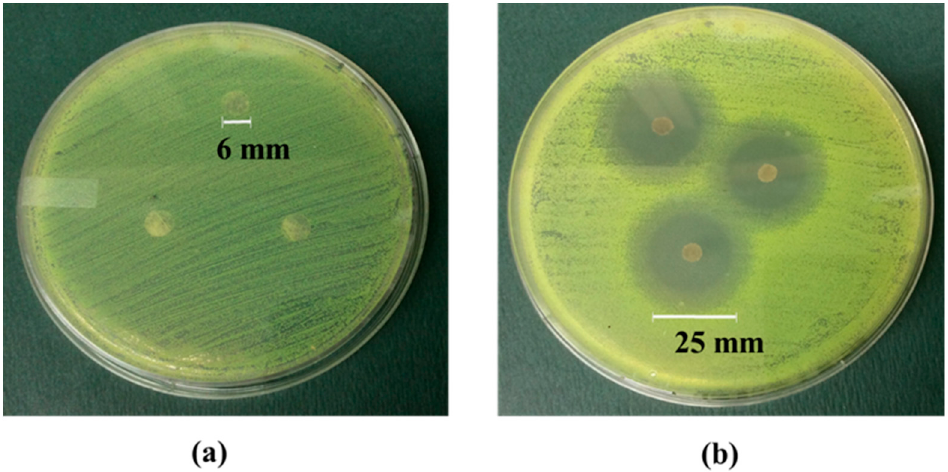
Figure 6. Antibacterial activity of ( a ) cellulose film and ( b ) cellulose-CdTe QDs film on S. aureus.